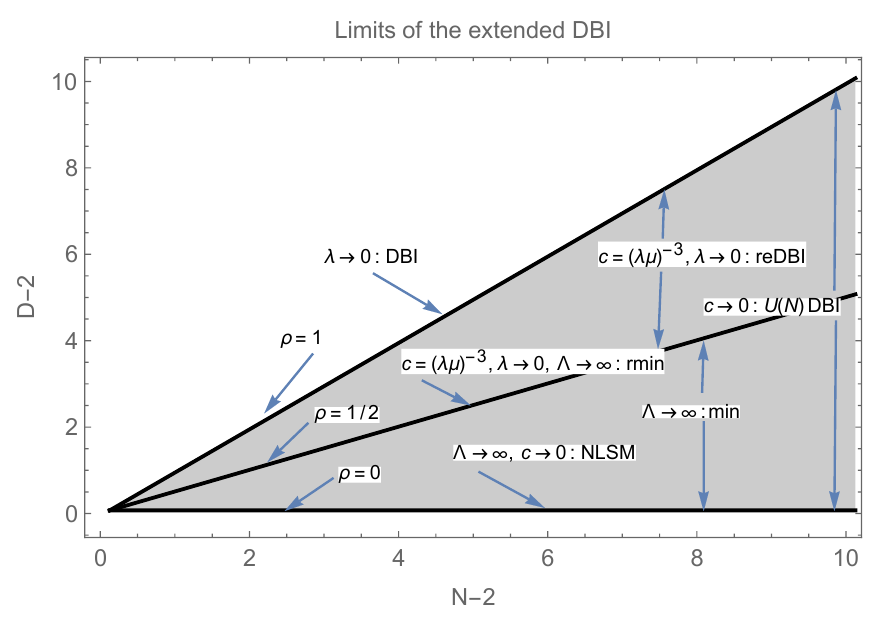
Figure 4 . Graphical representation of the various limits of the extended DBI in the ( N − 2 , D − 2)